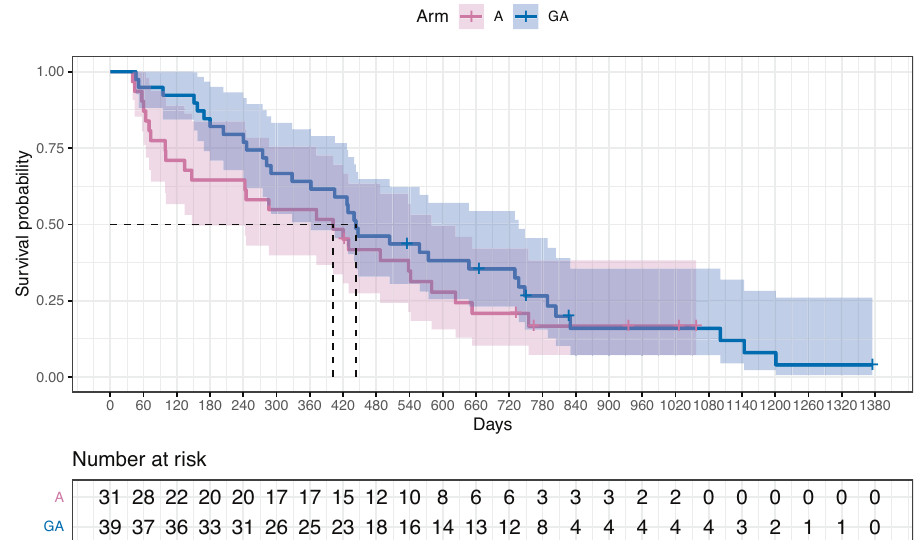
Fig. 1 Kaplan – Meier plot. Survival probability versus time (in days) for both treatment arms (GA vs A) of the clinical